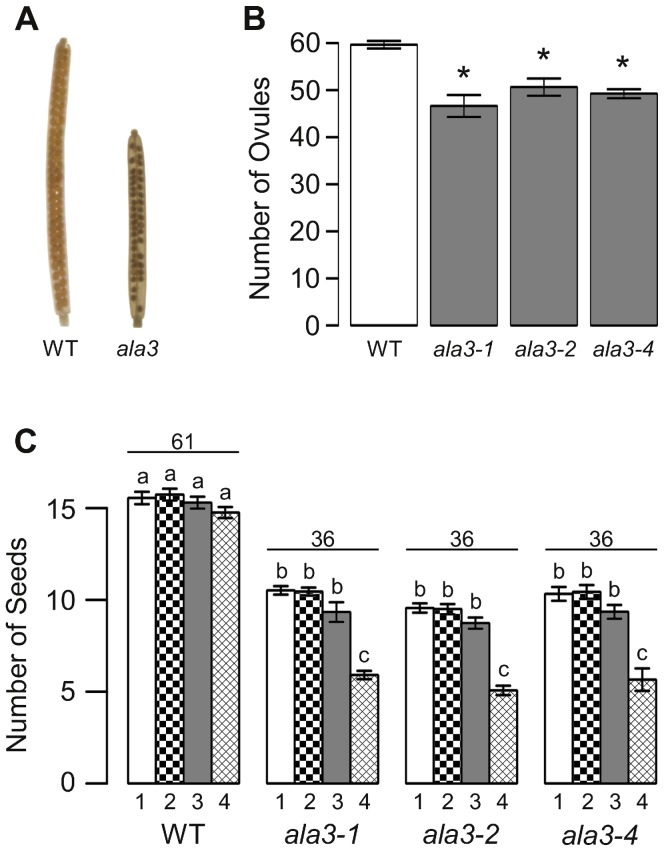
Loss of ALA3 results in reduced seed set with an uneven distribution of seed.(A) Representative examples of wild-type and ala3 siliques cleared with 70% EtOH to show seed positions. (B) Ovule number is reduced in ala3 pistils, but not sufficiently to account for the total reduction in seed set. Average results (±SE) are reported for two independent experiments, n = 14–18 pistils for ala3 mutants and n = 38 pistils for Col-0. Pistils were collected from a total of 5–6 different plants for each genotype. (C) Graph of seed set by sector. Siliques were divided into four sectors of equal length, with sector 1 at the top (stigma end) of the silique and sector 4 at the base of the silique. Average results (±SE) are reported for two independent experiments, n = 30–36 siliques. Siliques were collected from a total of 6–7 different plants for each genotype. Sector numbers appear below each column and the average total seed set for each genotype is given above the corresponding sector data. *Significantly different from wild-type (p<0.05, Welch’s t-test). a,b,cColumns sharing common labels (letters) are not significantly different from each other (p>0.05).